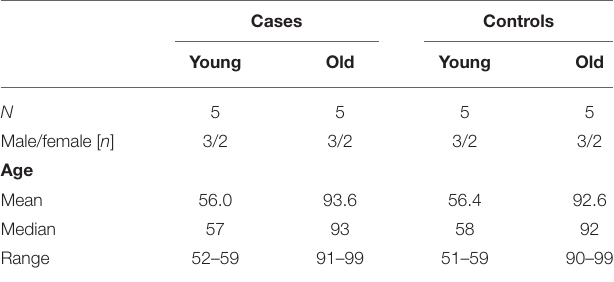
TABLE 1 | Demographic details of cases and